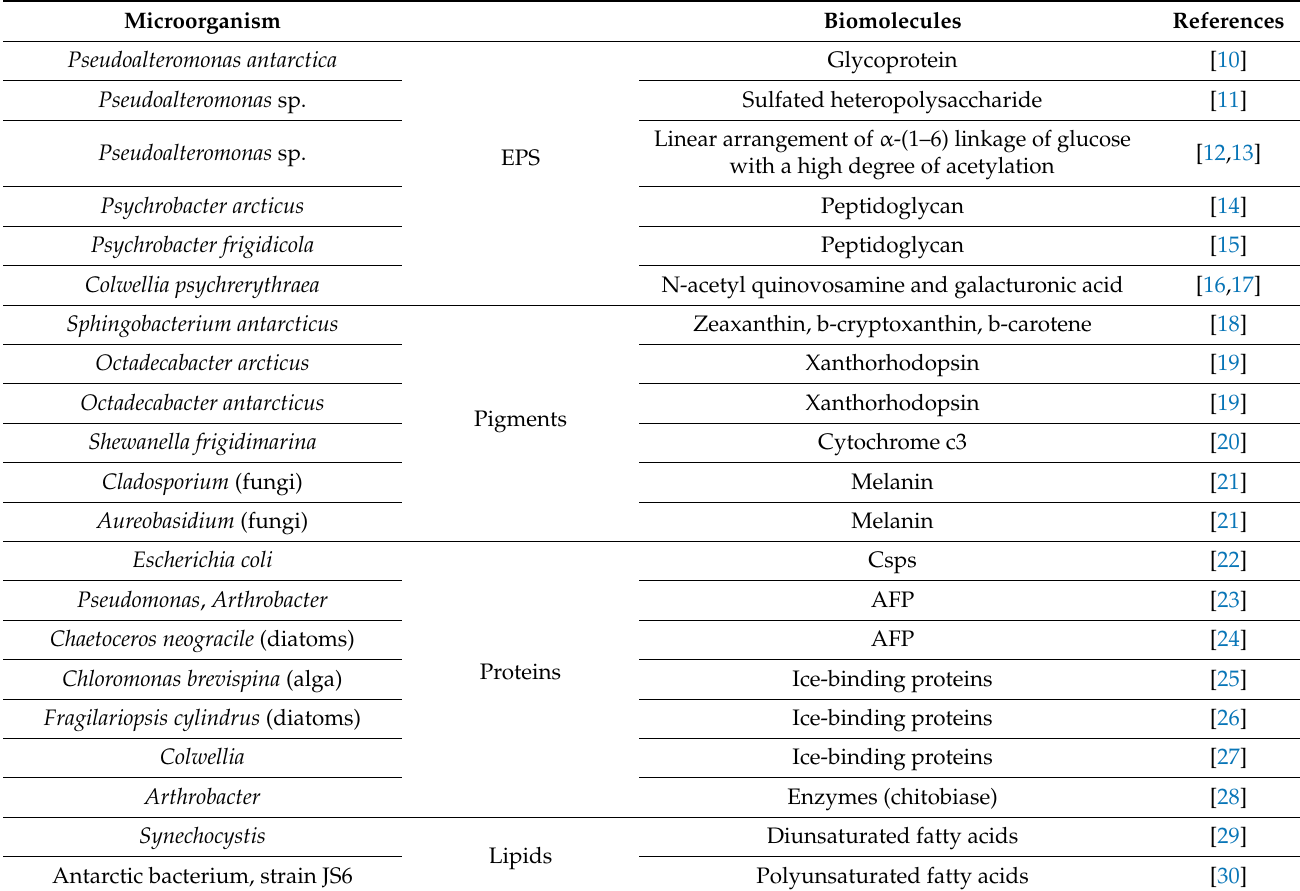
Table 1. Biomolecule-producing